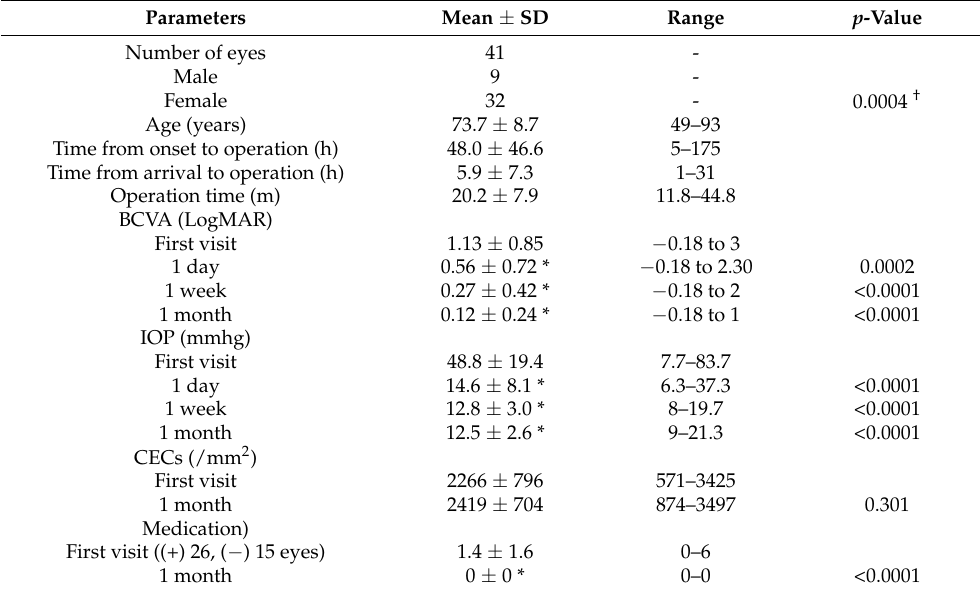
Table 1. Summary of results for the current study.